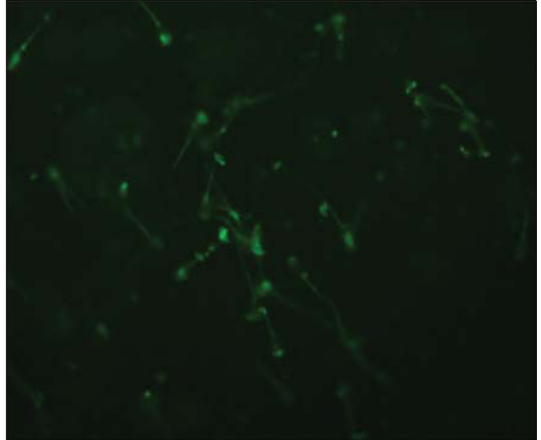
Figure-4: Sperm plasma membrane stained with Bodipy C11, FITC filter